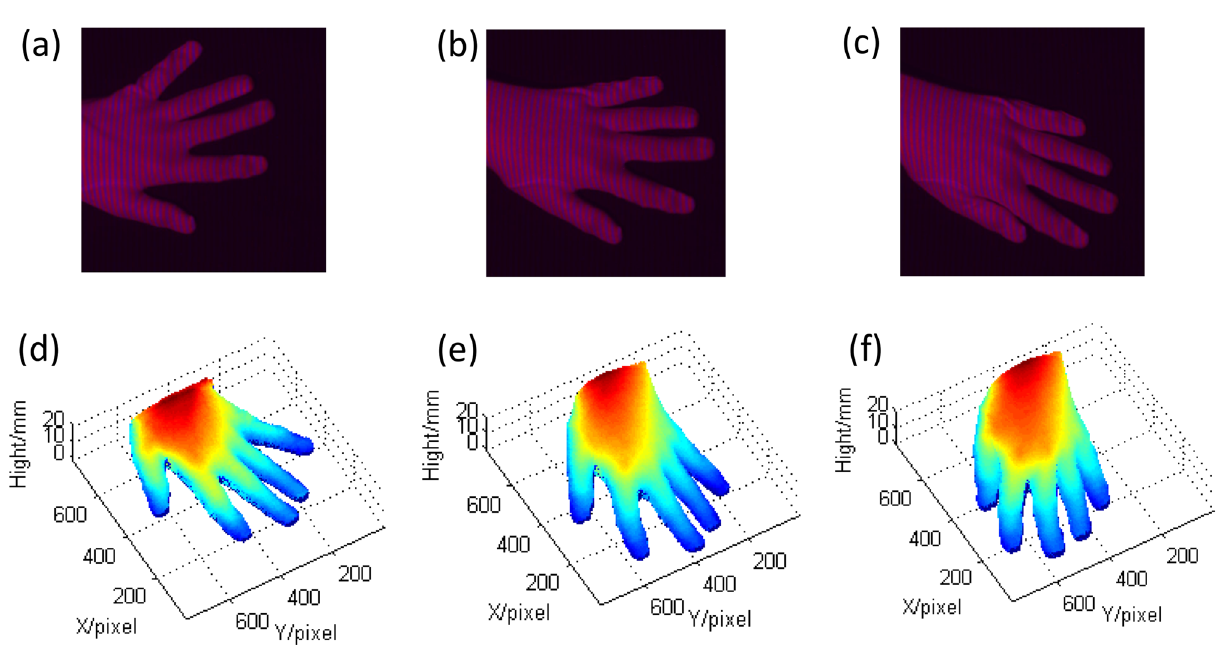
Figure 8. The measuring results of the dynamic hand at three random states. ( a )–( c ) The captured color deformed patterns at state1, state2, and state3, and they are integrated in Supplementary Video 1 (Supplementary Video 1, MP4, 1.16 MB); ( d )–( f ) the reconstructed hands at state1, state2, and state3, and they are integrated in Supplementary Video 2 (Supplementary Video 2, MP4, 346